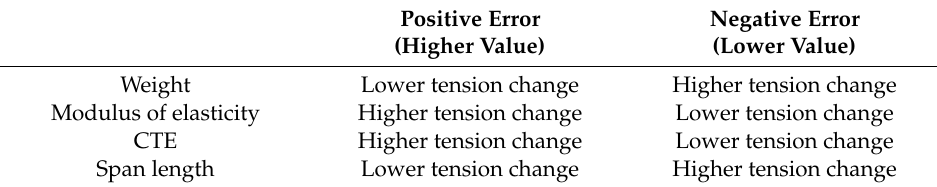
Table 2. Tension deviation as a function of the parameter error.